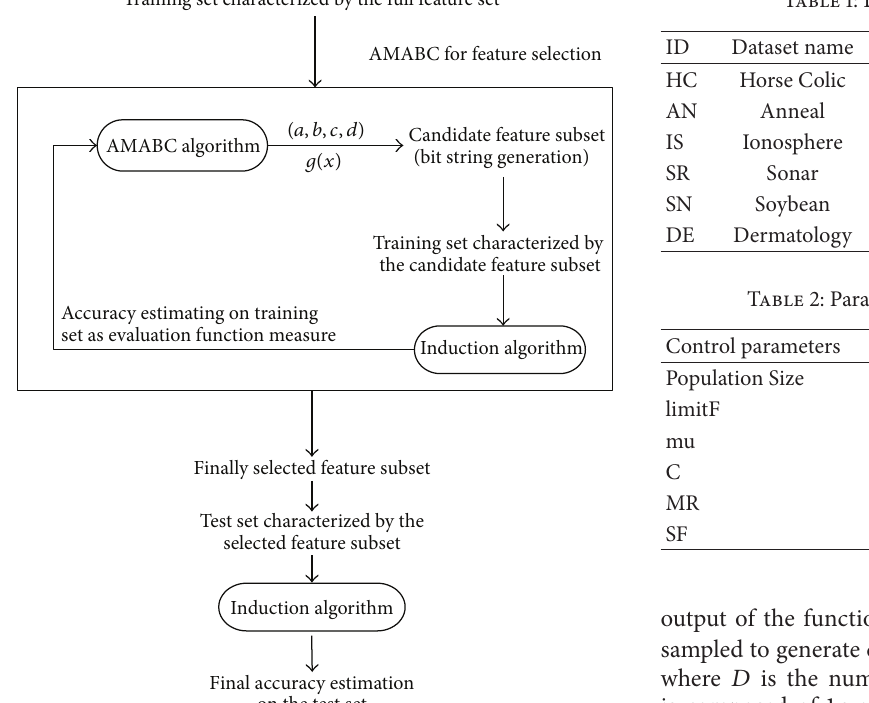
Table 1: Datasets used for experiments.